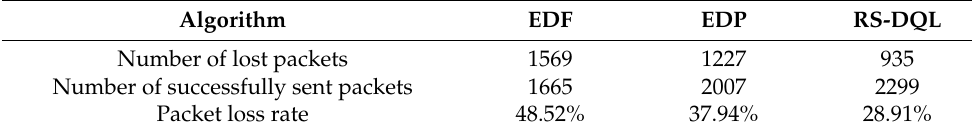
Table 3. Average number of lost packets for different algorithms.